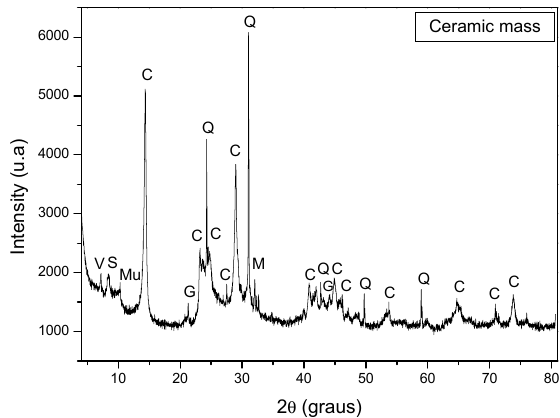
Figure 3. X-ray diffractogram of the ceramic mass. C = Kaolinite, Q = Quartz, G = Gibbysite, Mi = Microcline, Mu = Muscovite, S = Sepiolite, V = Vermiculite.